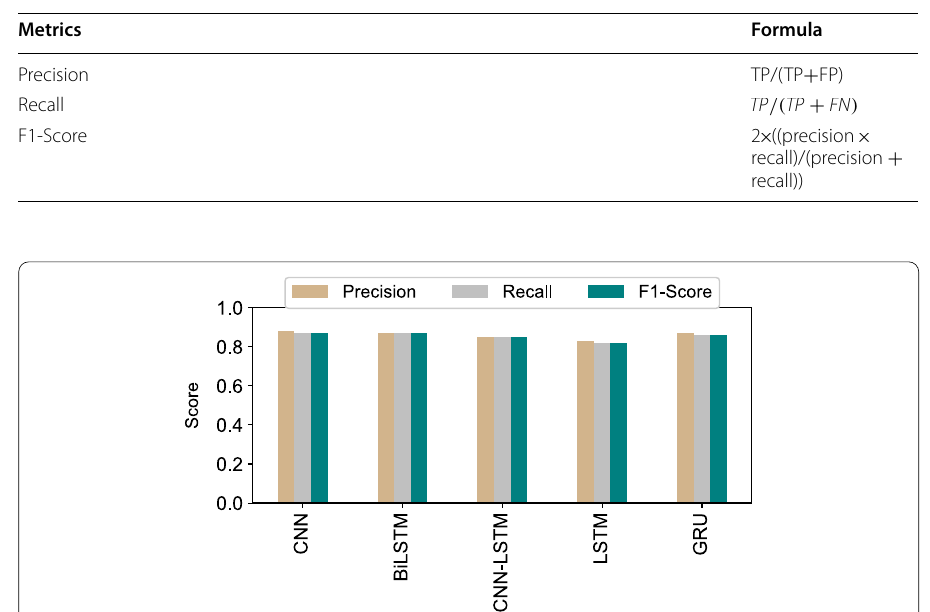
Table 4 Evaluation metrics